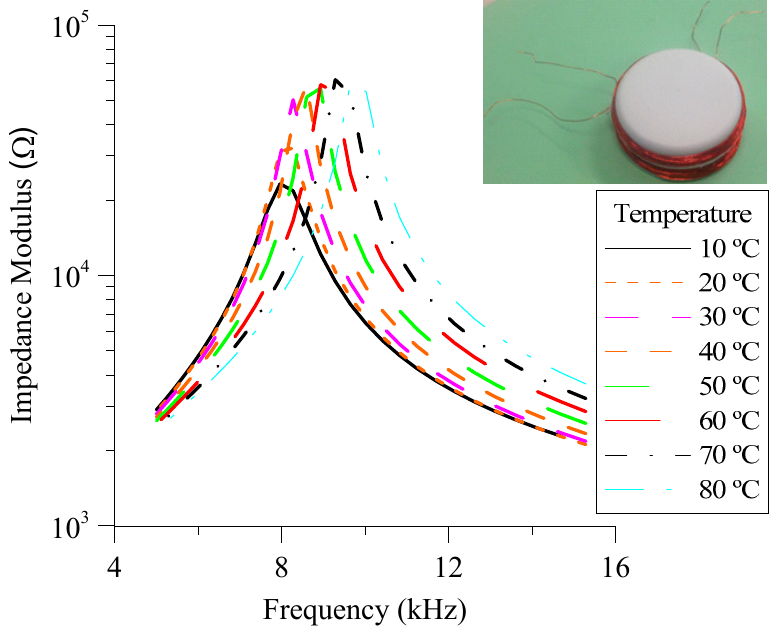
Figure 9. Impedance magnitude of the LC circuit as a function of the frequency for several temperatures. Inset: Prototype of the emitter and receiver antennas.